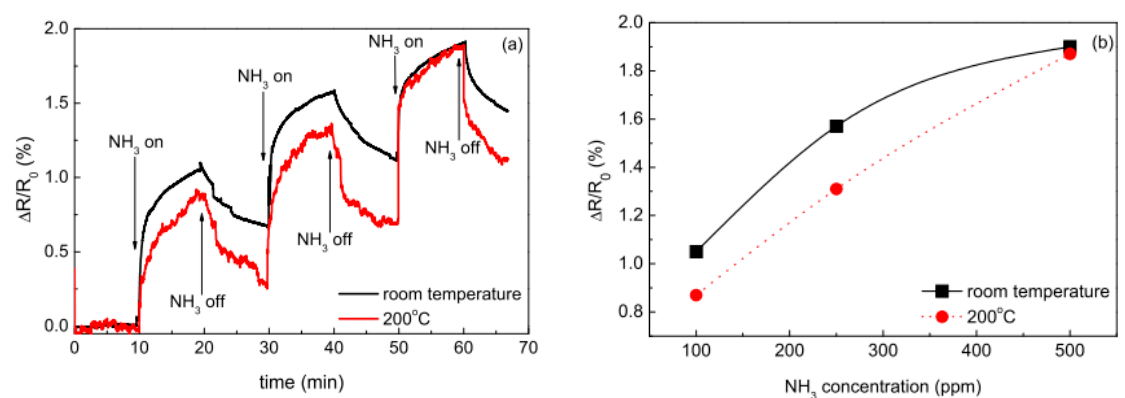
Figure 11. ( a ) ∆ R/R 0 curves in time for MWCNT sensor at room temperature and at 200 ◦ C (NH 3 concentrations were Figure 11. ( a ) Δ R/R 0 curves in time for MWCNT sensor at room temperature and at 200 °C (NH 3 concentrations were 100, 100, 250, and 500 ppm, respectively); ( b ) ∆ R/R 0 of the sensor depending on the concentration of ammonia [86]. With the 250, and 500 ppm, respectively); ( b ) Δ R/R 0 of the sensor depending on the concentration of ammonia [86]. With the per- permission of MDPI. mission of MDPI.